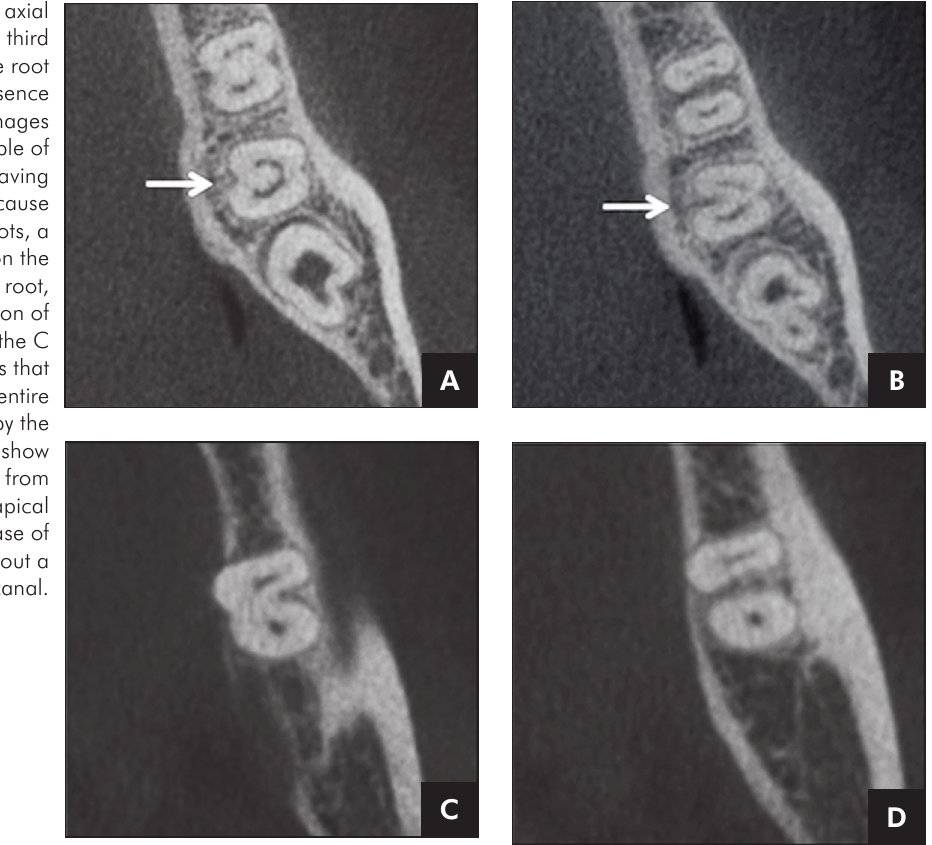
Figure 1 - Sequence of